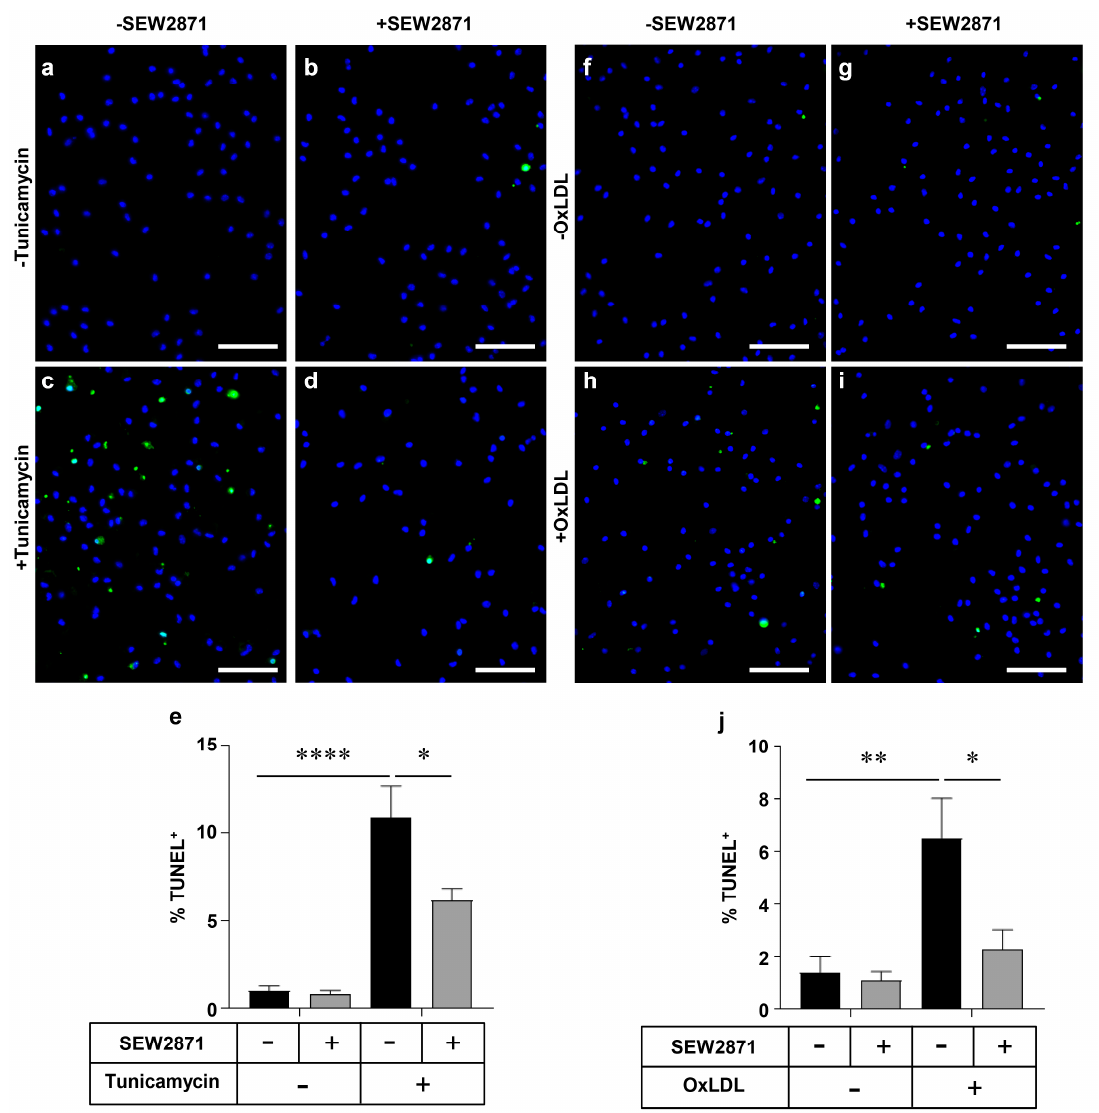
Figure 5. The S1PR1 selective agonist SEW2871 protects macrophages against tunicamycin- and oxLDL-induced apoptosis. Thioglycollate-elicited peritoneal macrophages collected from wild type ( WT ) mice were treated in culture with either tunicamycin (10 μ g/mL) or oxLDL (100 μ g protein/mL) in the presence of 1 μ m SEW2871 added as a 500× stock in DMSO. Control cells lacking SEW2871 treatment were treated with an equivalent volume of DMSO solvent. After 24 h, cells were fixed and apoptosis was detected by TUNEL staining (green fluorescence) as described in the Methods section. Nuclei were stained using DAPI (blue). ( a – d ) Representative images of TUNEL/DAPI-stained macrophages for tunicamycin-treated and control cells incubated with or without SEW2871; scale bars represent 50 μ m. ( e ) Quantification of the % of TUNEL + nuclei from tunicamycin-, SEW2871- and control-treated samples as a measure of the extent of apoptosis. n = 6, where each replicate represents cells prepared from a different mouse. ( f – i ) Representative images of TUNEL/DAPI-stained macrophages for oxLDL-treated and control cells incubated with or without SEW2871; scale bars represent 50 μ m. ( j ) Quantification of the % of TUNEL + nuclei from oxLDL-, SEW2871- and control-treated samples as a measure of the extent of apoptosis. n = 5, where each replicate represents cells prepared from a different mouse. Results are shown as means ± SEM. Data were analyzed by two-way ANOVA with Tukey’s multiple comparisons test; * p < 0.05, ** p < 0.01, **** p < 0.0001.